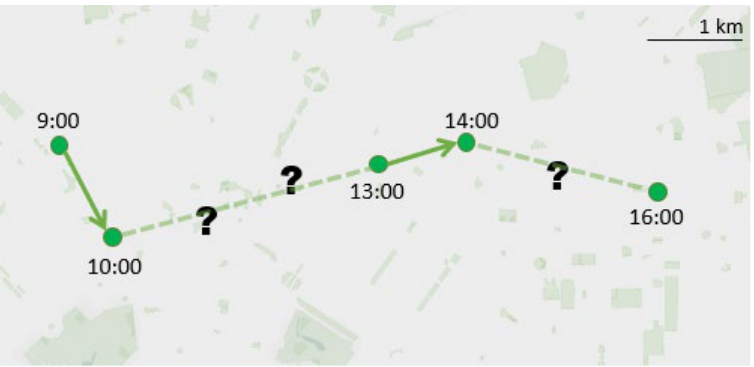
Figure 1. Trajectory reconstruction problem: predict the missing locations given the known recorded locations along the trace.